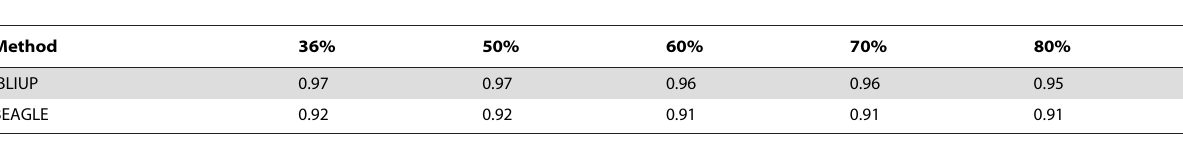
Table 4. Imputation accuracy of real pig sequencing